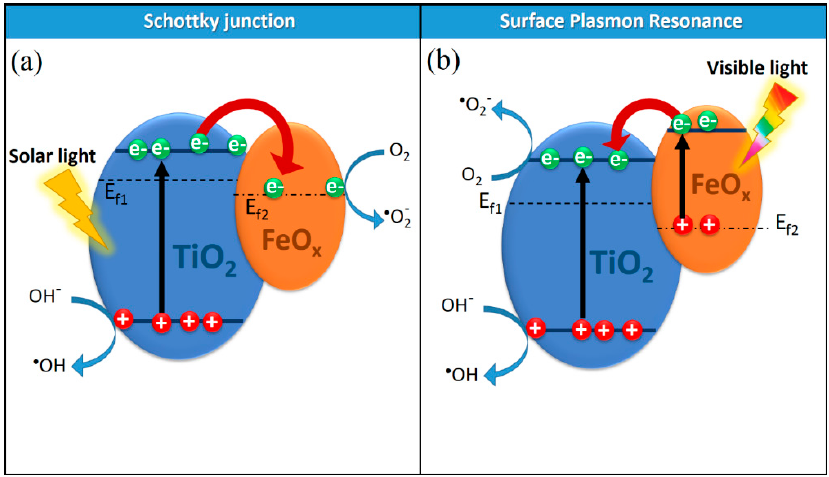
Figure 9. Equilibration of TiO 2 –FeO x nanocomposites with redox couple (bacteria) ( a ) before and ( b ) after irradiation.